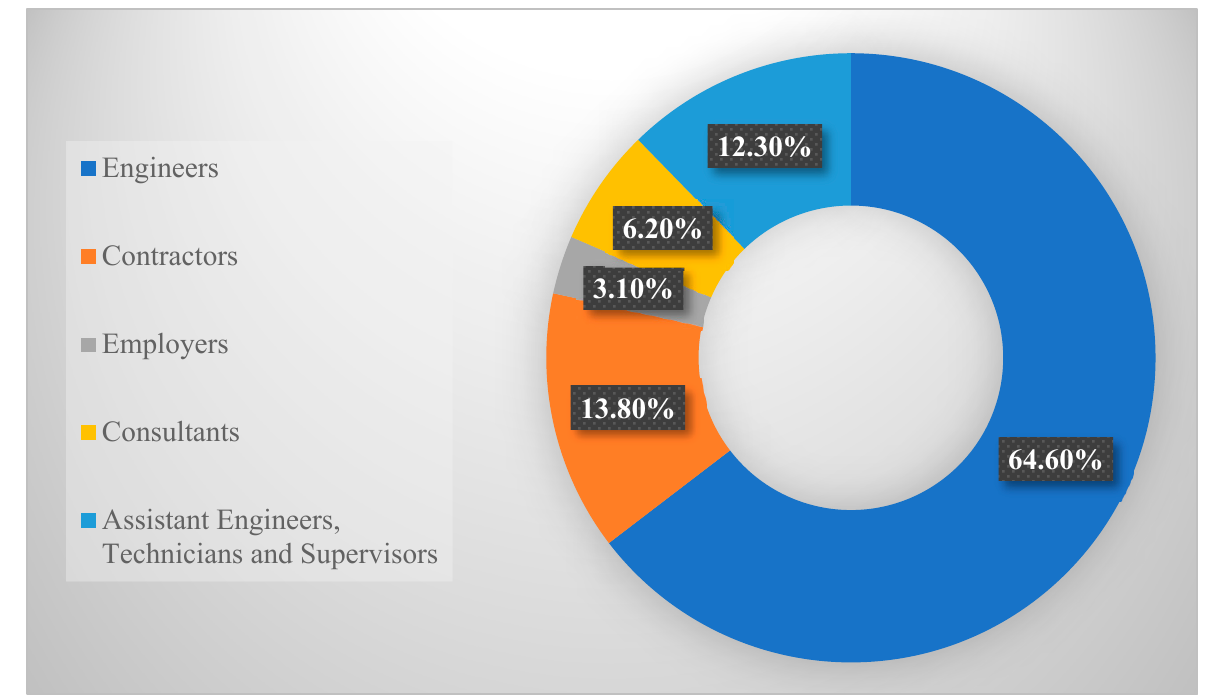
Figure 2. Distribution of respondents according to profession.